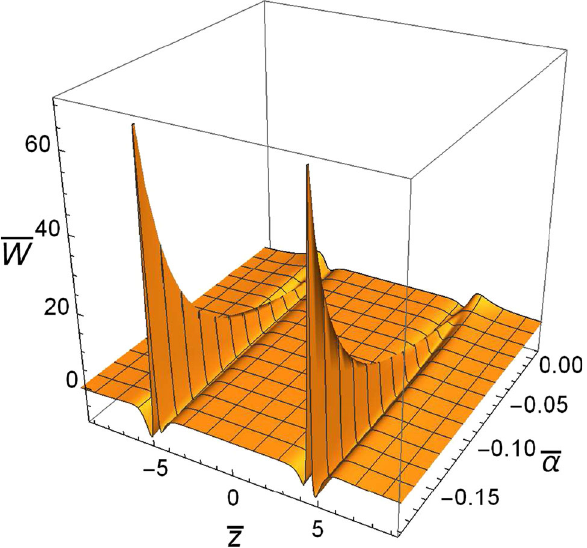
Fig. 9 The effect of the parameter ¯ α on the effective potential with ¯ b = 10 for case 1